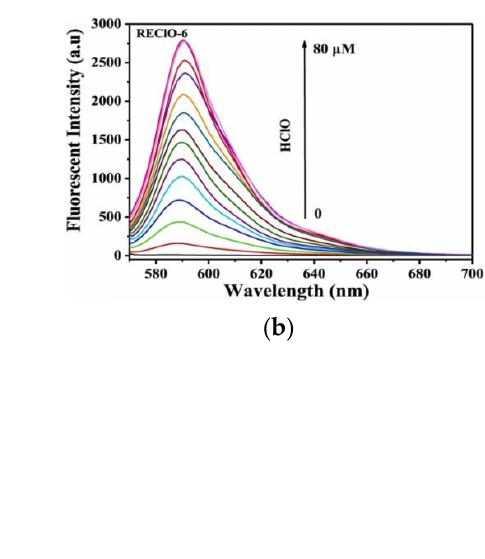
Figure 35. ( a ) The structure of probe REClO-6; ( b ) Fluorescence spectra of the probe REClO-6; ( c ) Fluorescence imaging of mice with different tumor sizes using REClO-6. Reproduced with per- mission from [154]. Copyright 2021 Elsevier B.V.